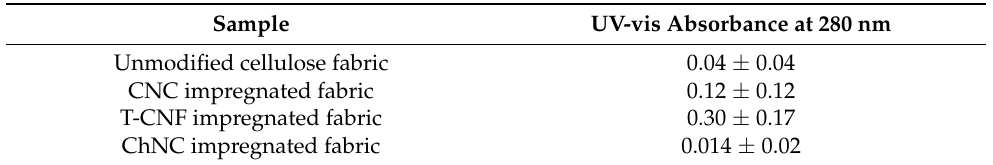
Figure 4. ( A ) Confocal microscopy micrographs showing BSA adsorption on the surface of the unmodified ( a ), CNC impregnated ( b ), T-CNF impregnated ( c ) and ChNC impregnated ( d ) nonwoven fabrics stained with the Qubit Protein Assay Kit after their incubation with BSA solution for 6 h at pH 7. ( B ) Confocal microscopy micrographs showing E. coli colonization and viability on the surface of the unmodified ( e ), CNC impregnated ( f ), T-CNF impregnated ( g ) and ChNC impregnated ( h ) nonwoven fabrics stained with Live/Dead BacLight Bacterial Viability Kit. Live cells were green stained by SYTO 9 and dead cells were red-stained by PI. Table 3. UV-vis absorbance of BSA at 280 nm for unmodified, CNC impregnated, T-CNF impregnated and ChNC impregnated nonwoven fabrics exposed to BSA solution for 6 h at pH 7.